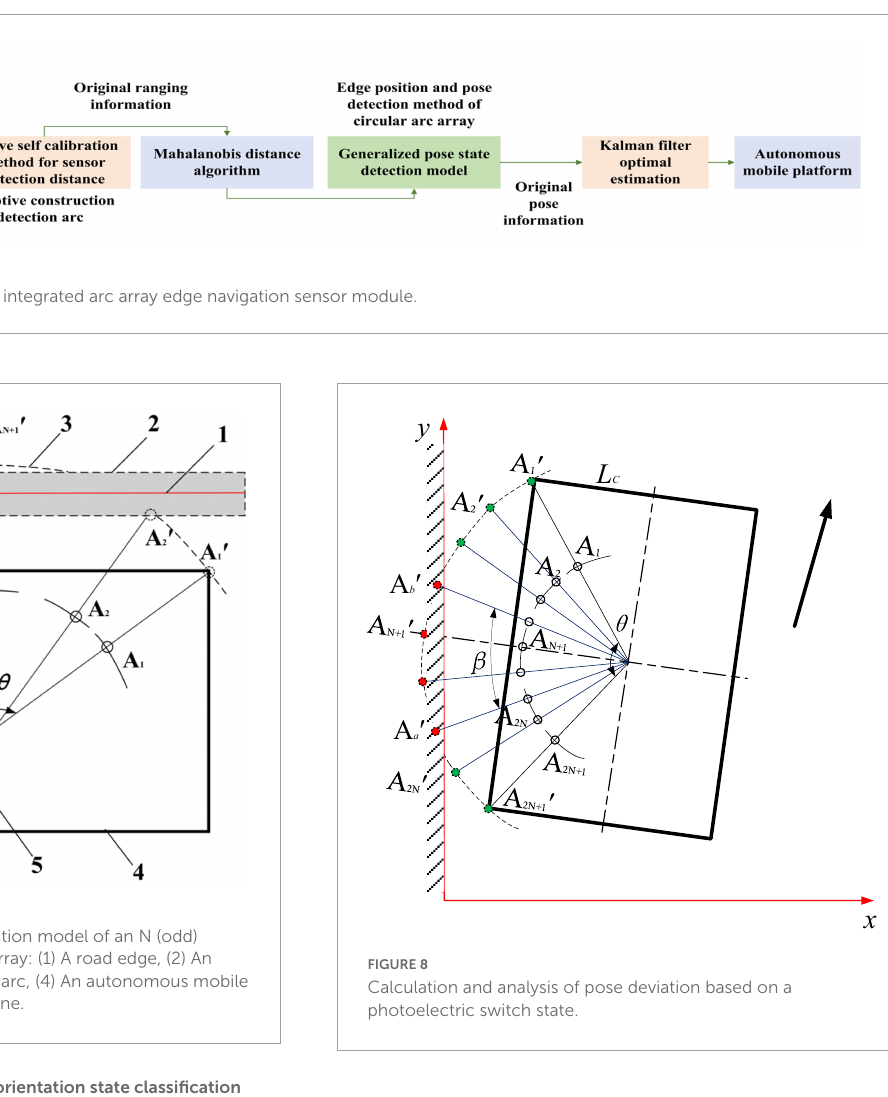
autonomous navigation platform has position and attitude deviation; as shown in Figure 8 , the green dot represents the non-triggered ranging sensor, and the red dot represents the triggered ranging sensor. The edge pose state detection and judgment rules of unknown sensor number are established according to the previous research of the author (Ju et al., 2017), as shown in formula (1). The tolerance range of the calculation error of the heading deviation and transverse deviation of the autonomous navigation platform relative to the road edge can be further simplified, as shown in Formula (2). As shown in Table 1 , the two parameters, signal trigger number N d and trigger center serial number N f , are used to judge the relative pose state type of the autonomous navigation platform along the road. The larger the N d is, the closer the autonomous navigation platform is to the road edge; on the contrary, the smaller the N d is, the farther the autonomous navigation platform is from the road edge. N f is the average value of the serial